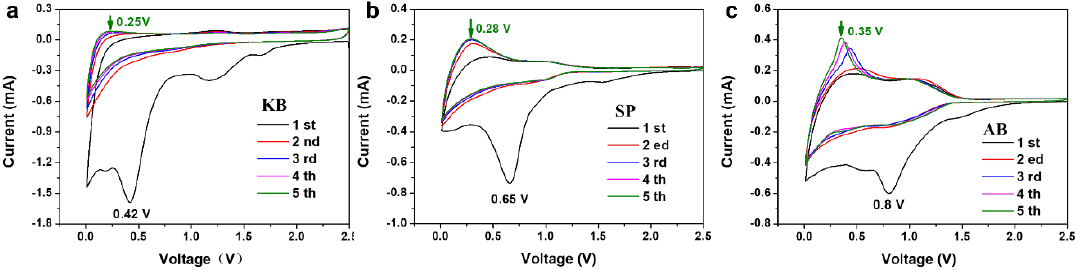
Figure 5. CV curve for the first five cycles of the silica aerogel when KB ( a ), SP ( b ), and AB ( c ) as conductive agents. conductive agents.